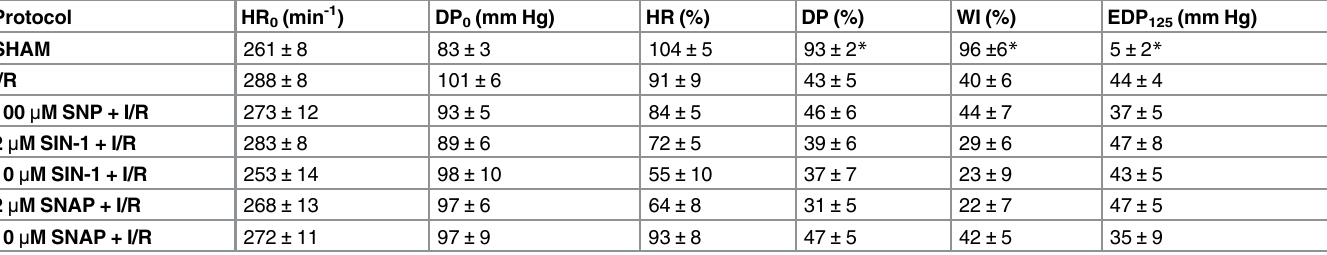
Table 1. Hemodynamic parameters of the rat hearts after exposure to the different experimental protocols.